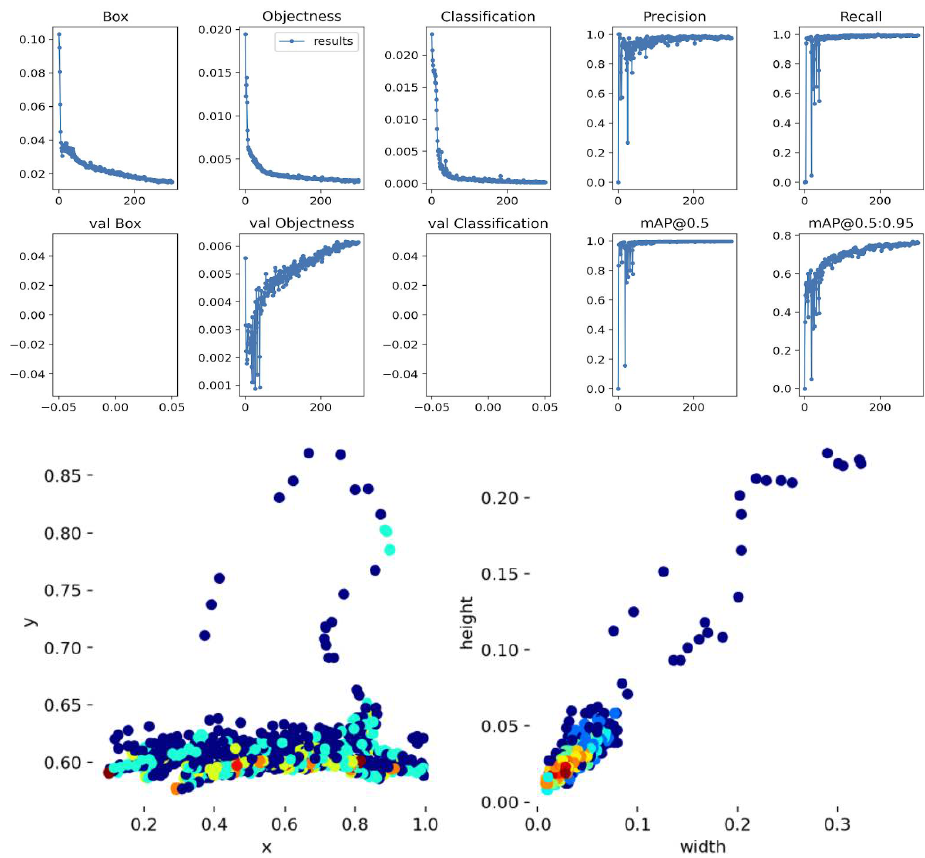
Figure 4. ( top ) Fine-tuning the trained network using sampled data from the initial detector results and additional labels and object classes. ( bottom ): network prediction confidence of the data points. All datapoint x/y positions were normalized. The dark blue indicates high confidence. The warm color indicates low confidence. The low confidence data points became more frequent as the target distance increased. All dimensions are normalized.